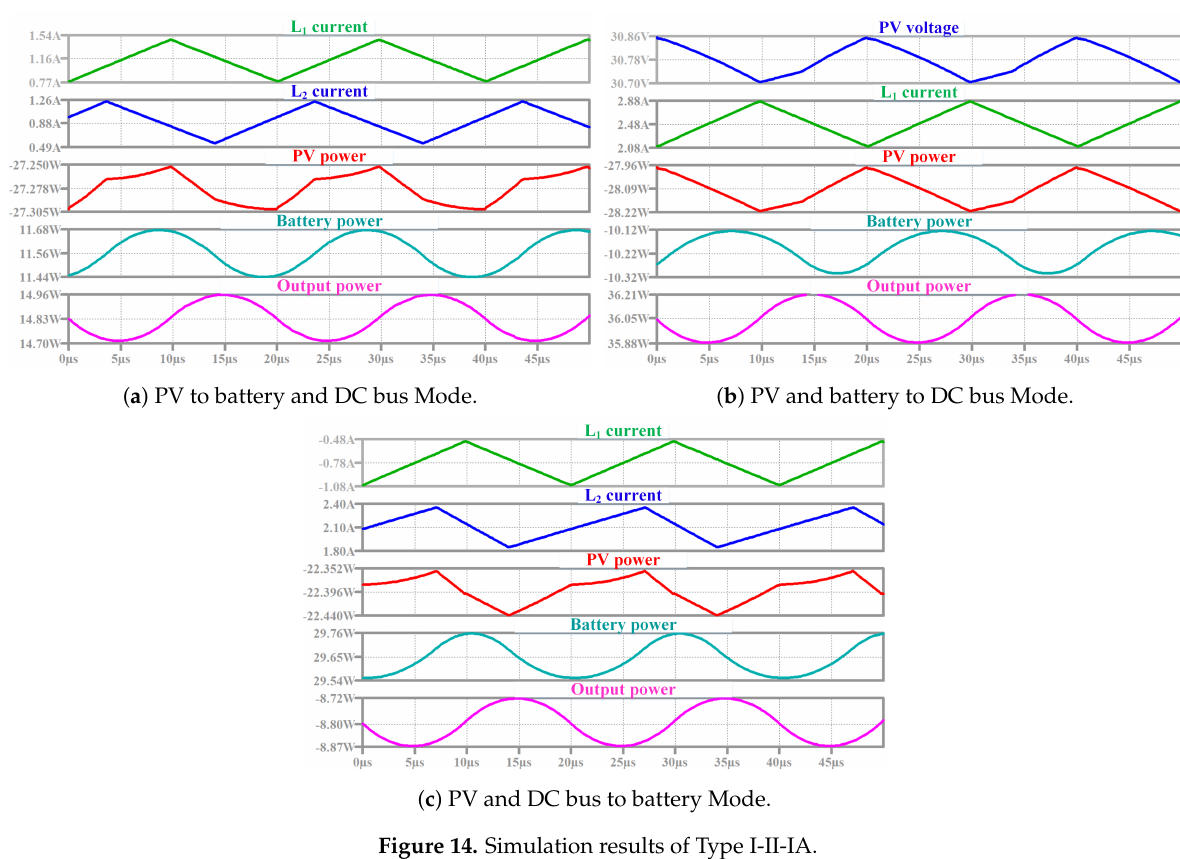
Figure 14. Simulation results of Type I-II-IA.